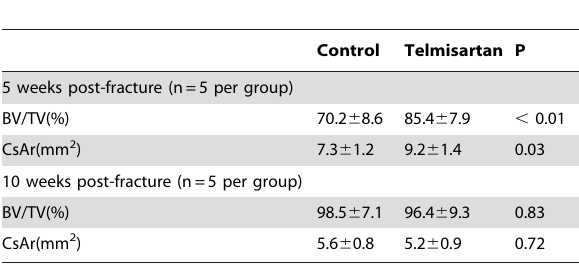
Table 3. Micro-CT analysis of the callus of telmisartan-treated and vehicle-treated animals at 5 and 10 weeks after fracture